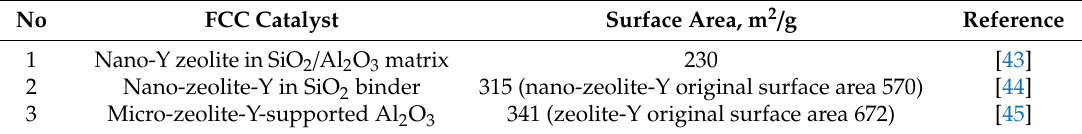
Table 4. Surface areas of nano- and micro-zeolite-Y-based fluid catalytic cracking (FCC) catalysts. No FCC